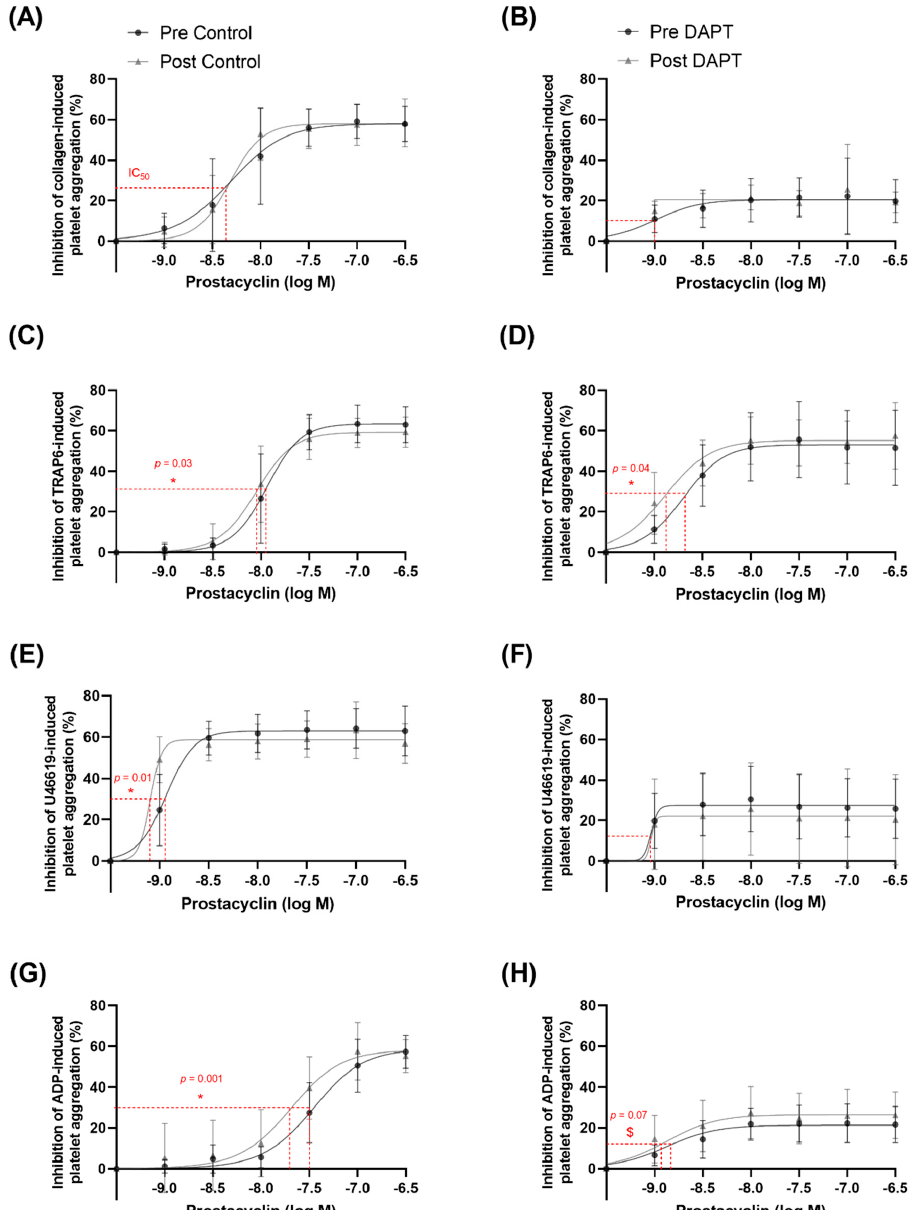
Figure 5. The half maximal inhibitory concentration (IC 50 ) for inhibition of platelet aggregation by prostacyclin (1–300 nM) with ( B , D , F , H ) or without ( A , C , E , G ) dual anti-platelet therapy (DAPT). ( A ) collagen ( n = 12), ( B ) collagen with DAPT ( n = 12), ( C ) thrombin receptor activator peptide 6 (TRAP6; n = 13), ( D ) TRAP6 with DAPT ( n = 13), ( E ) U46619 ( n = 12), ( F ) U46619 with DAPT ( n = 12), ( G ) adenosine 5 (cid:48) -diphosphate (ADP) ( n = 12), and ( H ) ADP with DAPT ( n = 12). *, indicates a statistically significant decrease with training. $, indicates a trend for a decrease with